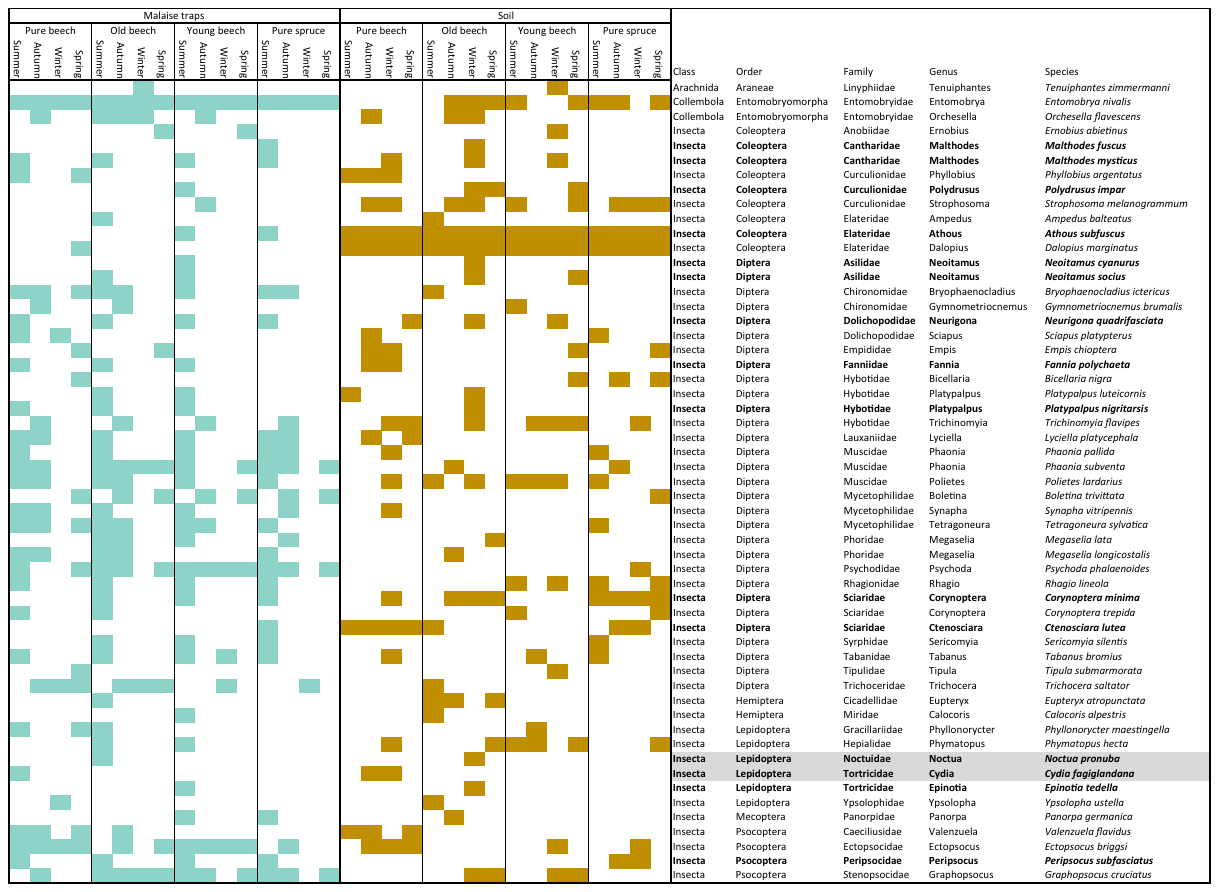
Table 1. Insect species (BlastID ≥ 99%) found in either of the two study substrates soil and Malaise samples at each forest type per season. Life cycles of the two lepidopteran species highlighted in grey are described in detail in the manuscript. Species highlighted in bold are mentioned in the results